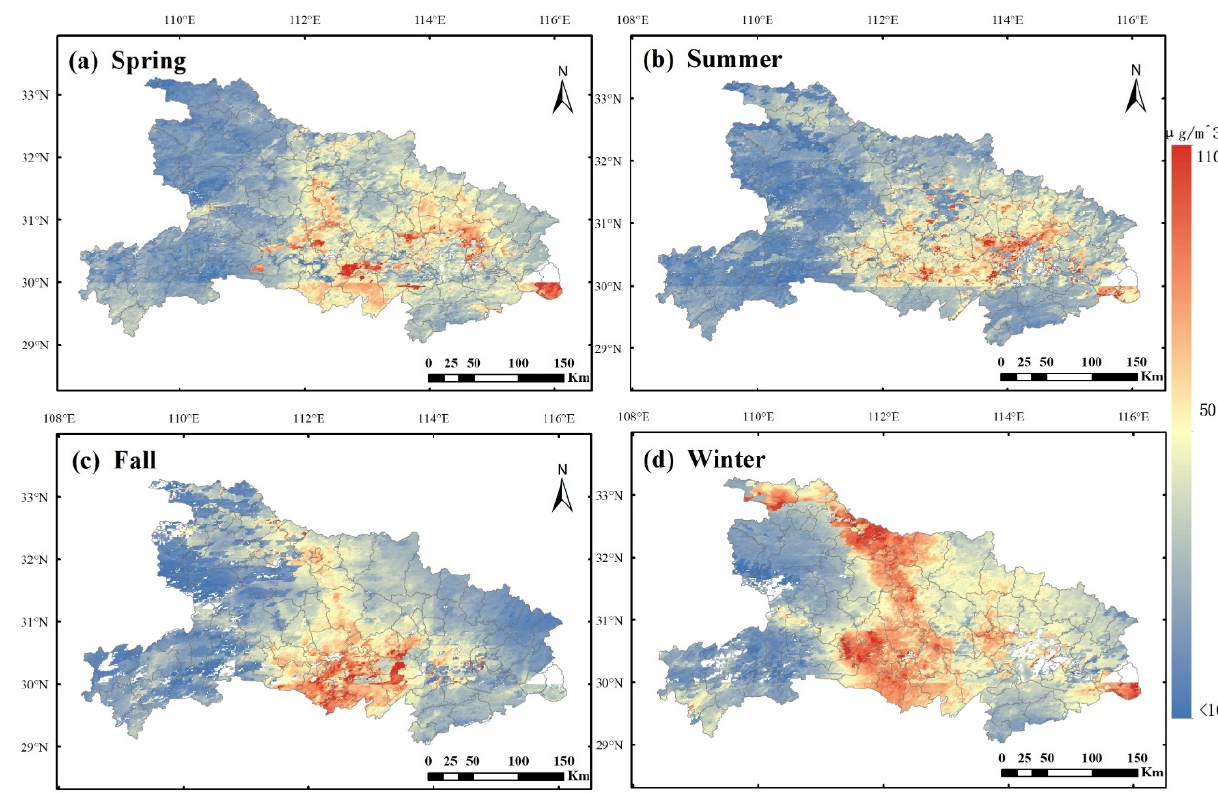
Figure 6. The distribution of and variation in averaged PM 2.5 estimations in four seasons ( a ) for spring, ( b ) for summer, ( c ) for autumn, and ( d ) for winter) in the study area of Hubei, China.